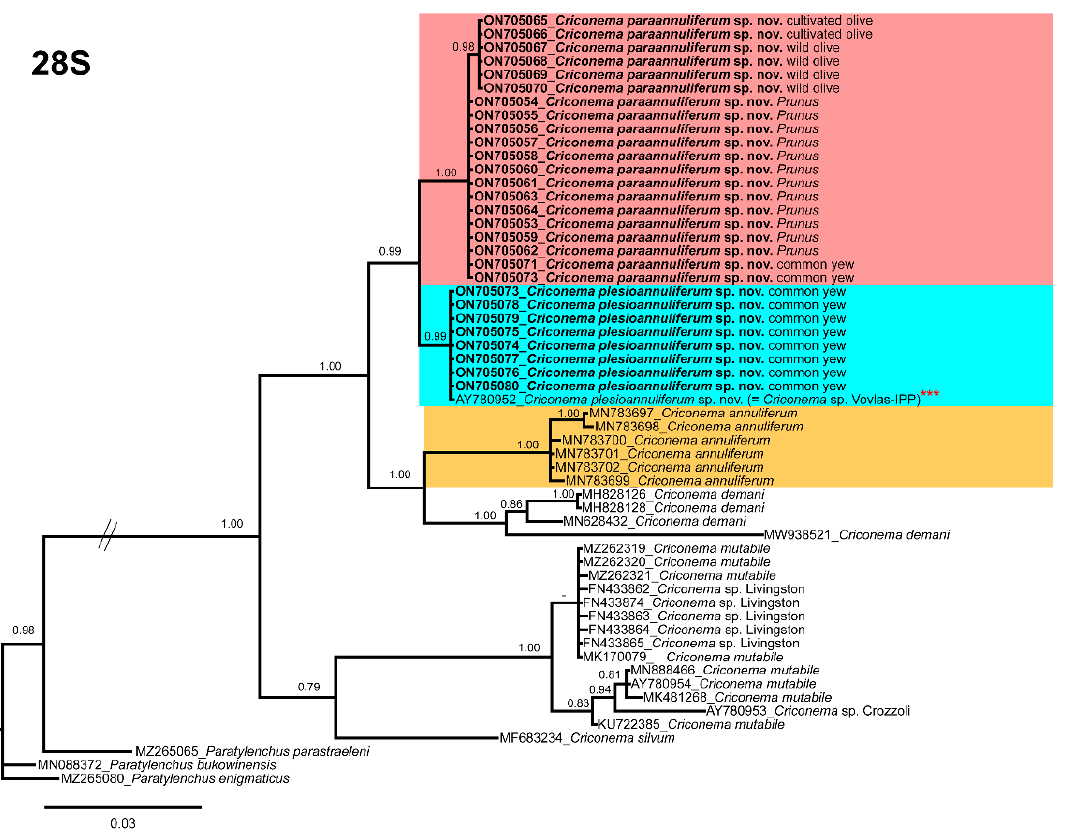
Figure 13. Phylogenetic relationships within the genus Criconema . Bayesian 50% majority rule consensus tree as inferred from D2-D3 expansion domains of the 28S rRNA sequence alignment under the general time-reversible model of sequence evolution with a gamma-shaped distribution (GTR + G). Posterior probabilities of more than 0.70 are given for appropriate clades. Newly obtained sequences in this study are in bold. The scale bar indicates expected changes per site, and the coloured boxes indicate the clade association of the Criconema annuliferum -complex. *** Initially identified in NCBI as Criconema sp. Vovlas-Italy.